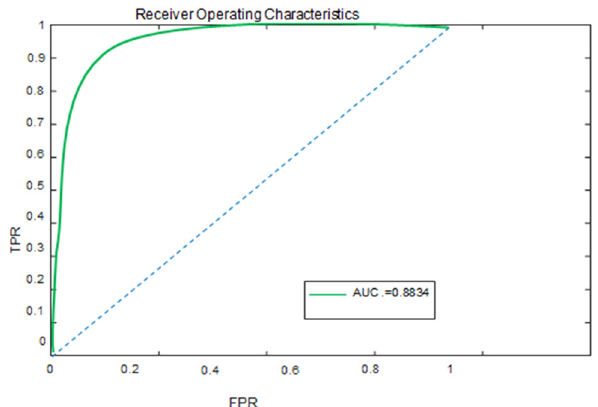
Figure 7: The second scenario strong accurate